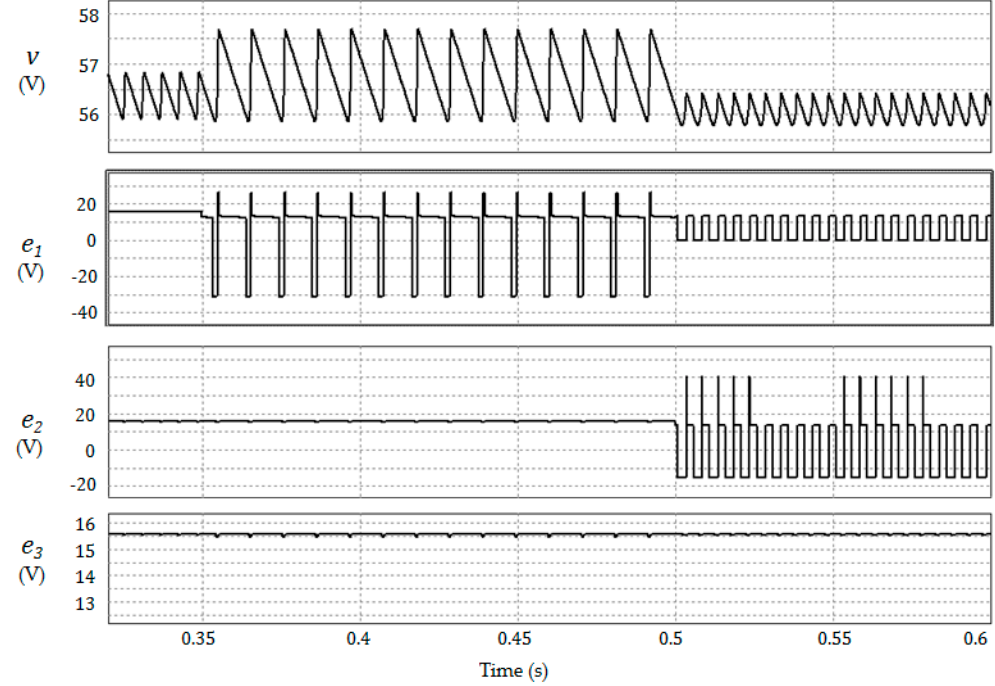
Figure 4. PI closed-loop behavior with 𝑒 (cid:2869) ,𝑒 (cid:2870) towards open circuits to 0.35 and 0.5 s respectively.